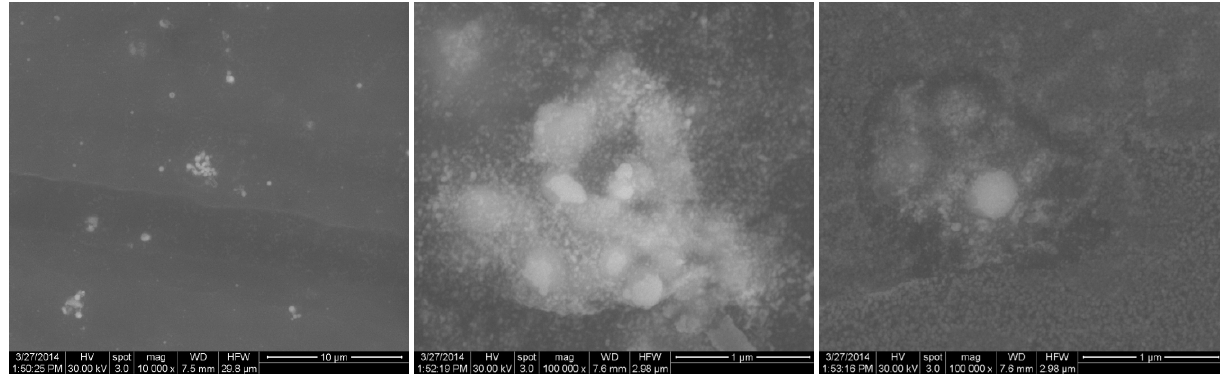
O @CV thin coating prepared by 3 4